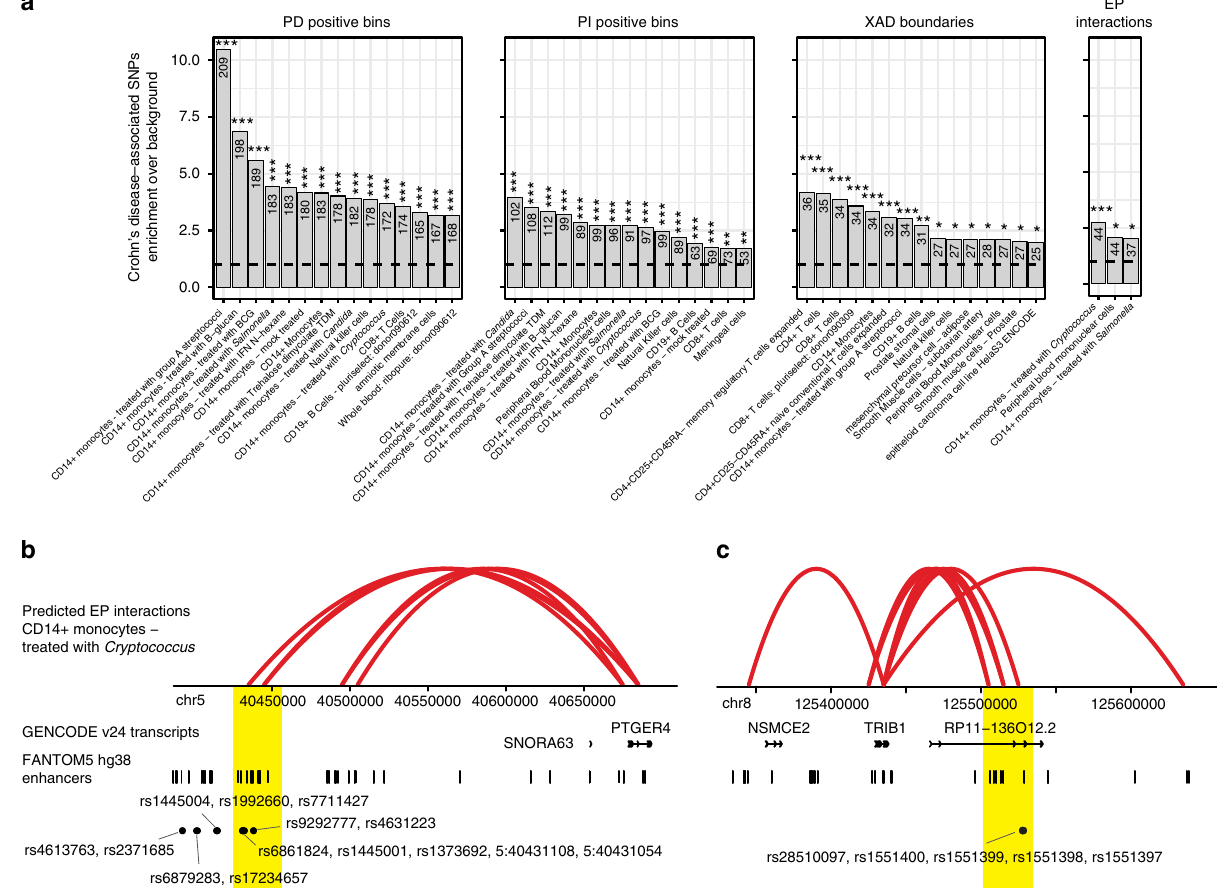
Fig. 7 Analysis of Crohn ’ s-disease associated SNPs reveals cell-type preferences and regulatory associations. a Crohn ’ s disease SNP enrichments in transcriptional components, XAD boundaries and inferred enhancer – promoter interactions (FDR-corrected χ 2 tests based on the PD/PI positive bins or the presence of XAD boundaries/target enhancers per cell type, and trait-associated SNPs). See also Supplementary Figure 16 for enrichments in lymphoid leukaemia. Signi fi cance stars above bars are interpreted as: * P < 0.1, ** P < 0.01 or *** P < 0.001. b , c Predicted EP interactions in CD14+ monocytes treated with Cryptococcus , for genes PTGER4 ( b ) and TRIB1 ( c ) for which interacting enhancers overlap or are in close proximity with disease-associated SNPs (highlighted in yellow). Predicted EP interactions, GENCODE v24 transcripts, FANTOM5 enhancers and the locations of relevant SNPs are displayed